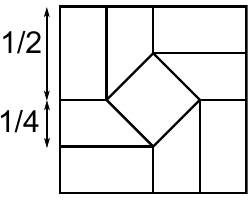
Fig. 6. Crease pattern for square twist.